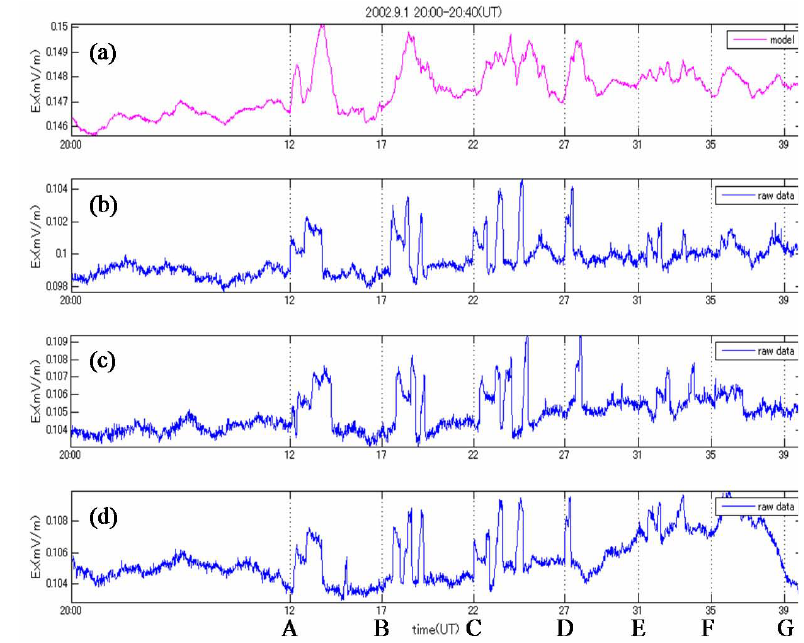
Fig. 16. An example of the monthly averaged data for a model of a DC-driven train noise and real observed data at KYS station. (a) A monthly averaged model of the Ex component for September 2002, (b) Ex component for 1 September 2002, (c) Ex component for 2 September 2002, and (d) Ex component for 3 September 2002.